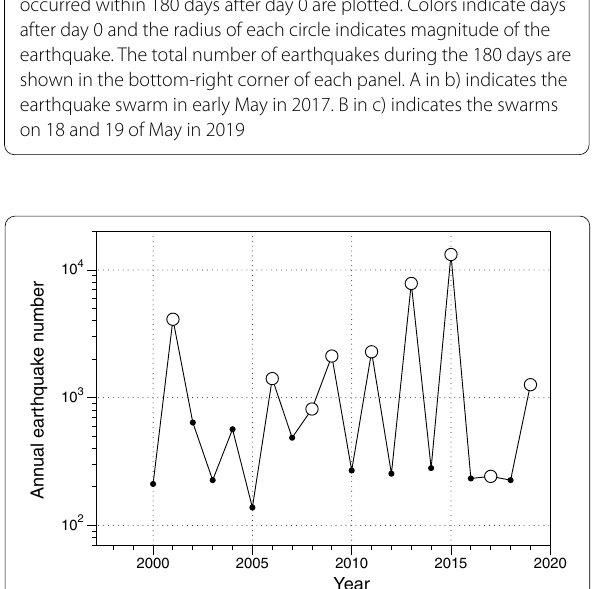
Fig. 5 Annual number of volcano-tectonic earthquakes in Hakone volcano detected by routine analysis of Hot Springs Research Institute of Kanagawa Prefecture. Open circles indicate years that underwent volcanic unrest, while dots indicate years without